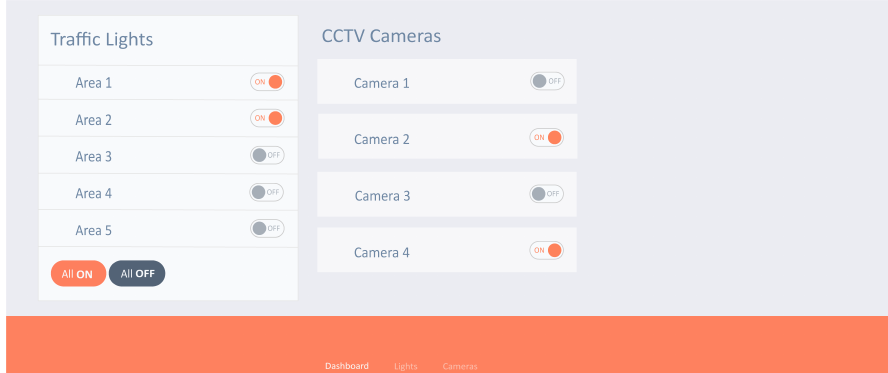
Figure 21. Client